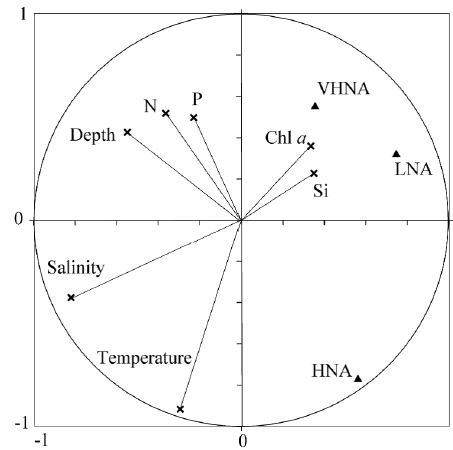
Figure 7. Correlation plot of the redundancy analysis (RDA) on the relationships between the environmental variables and the three subgroups of heterotrophic prokaryotes observed during the cruise (LNA, HNA, VHNA). Chl a , N, P, and Si stand for chlorophyll a , nitrate, phosphate, and silicic acid,